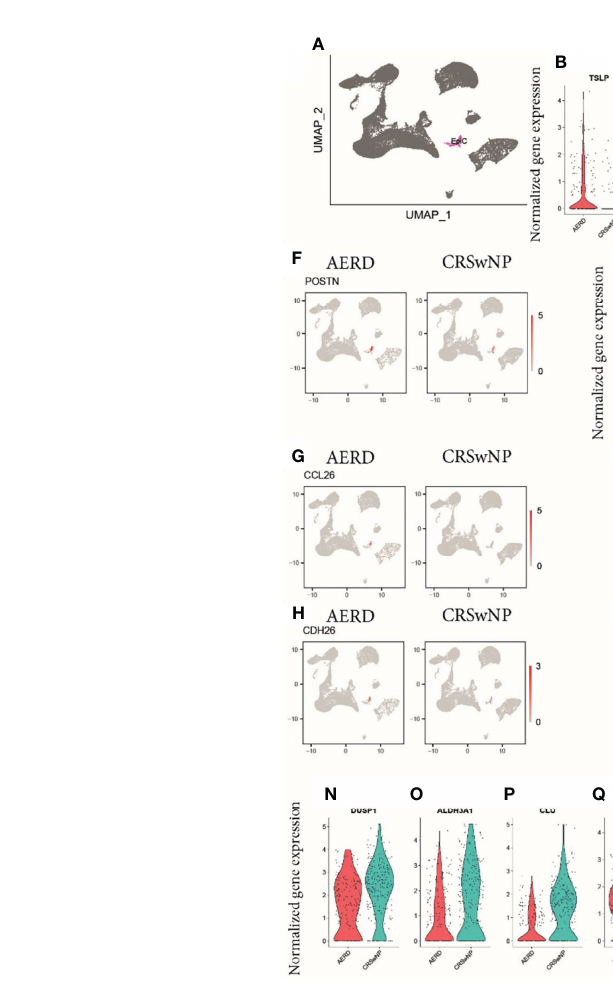
FIGURE 4 | Gene expression of epithelial cells of patients with AERD or CRSwNP. (A) Color-coded UMAP plot of scRNA-seq epithelial cell cluster. (B, C) Violin plots showing natural log-transformed normalized gene expression for (B) TSLP and (C) IL33 in AERD (red) versus CRSwNP (blue) patients. (D, E) Quantitative real- time PCR of bulk nasal tissue isolates for (D) TSLP and (E) IL33 con fi rming scRNA-seq data. Line represents median values, and p-values are indicated in plots. (F – H) Feature plots identifying (F) POSTN , (G) CCL26 , and (H) CDH26 in patients with AERD (left) and CRSwNP (right). (I – K) violin plots showing natural log- transformed normalized gene expression for (I) CD44 , (J) FGFR1 , and (K) CTSC in AERD (red) versus CRSwNP (blue) patients. (L, M) Feature plots identifying (L) SERPINE1 and (M) ALOX15 in patients with AERD (left) and CRSwNP (right). (N – Q) Violin plots showing natural log-transformed normalized gene expression for DEG downregulated in AERD (red) versus CRSwNP (blue) patients. Feature plots: red color displays intensity levels of natural log-transformed gene expression. AERD, aspirin-exacerbated respiratory disease; CRSwNP, chronic rhinosinusitis with nasal polyps; DEG, differentially expressed genes; UMAP, Uniform Manifold Approximation and Projection; scRNA-seq, single-cell RNA